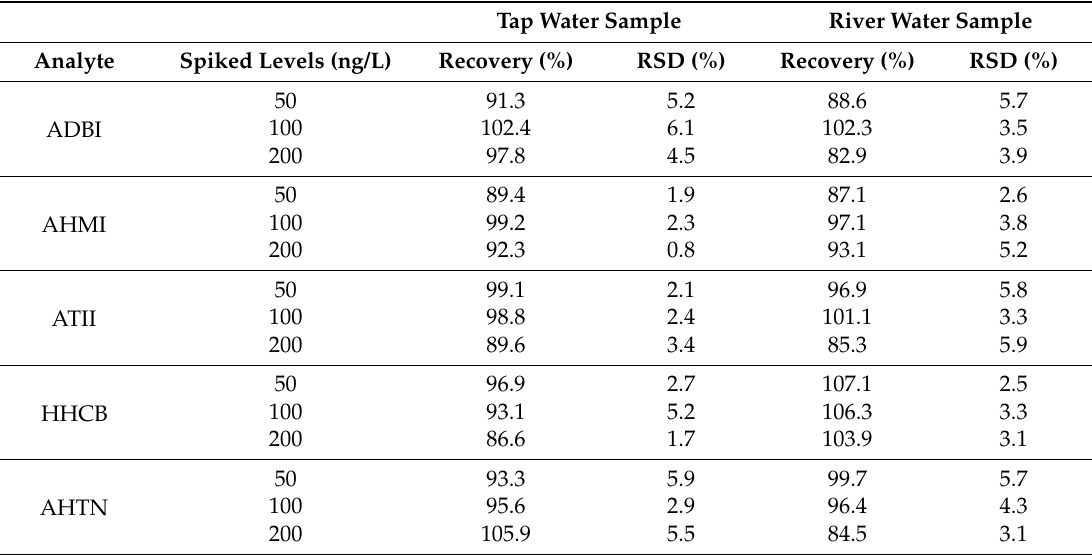
Table 2. Recovery studies on tap water and river water samples containing